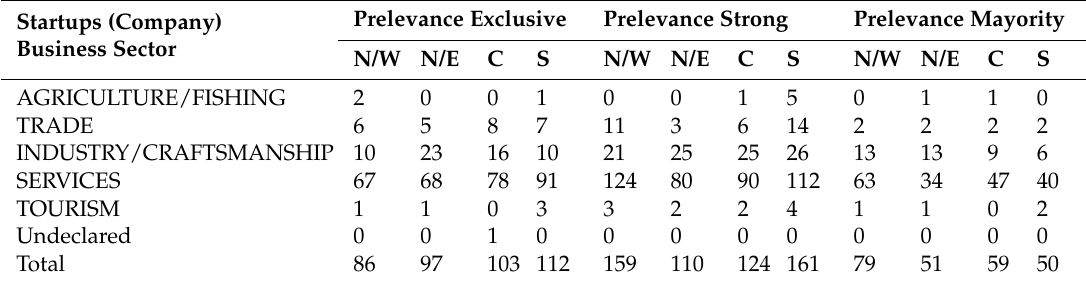
Table 11. Type of Italian woman startups (WSU) to geographical macroarea and to type of business